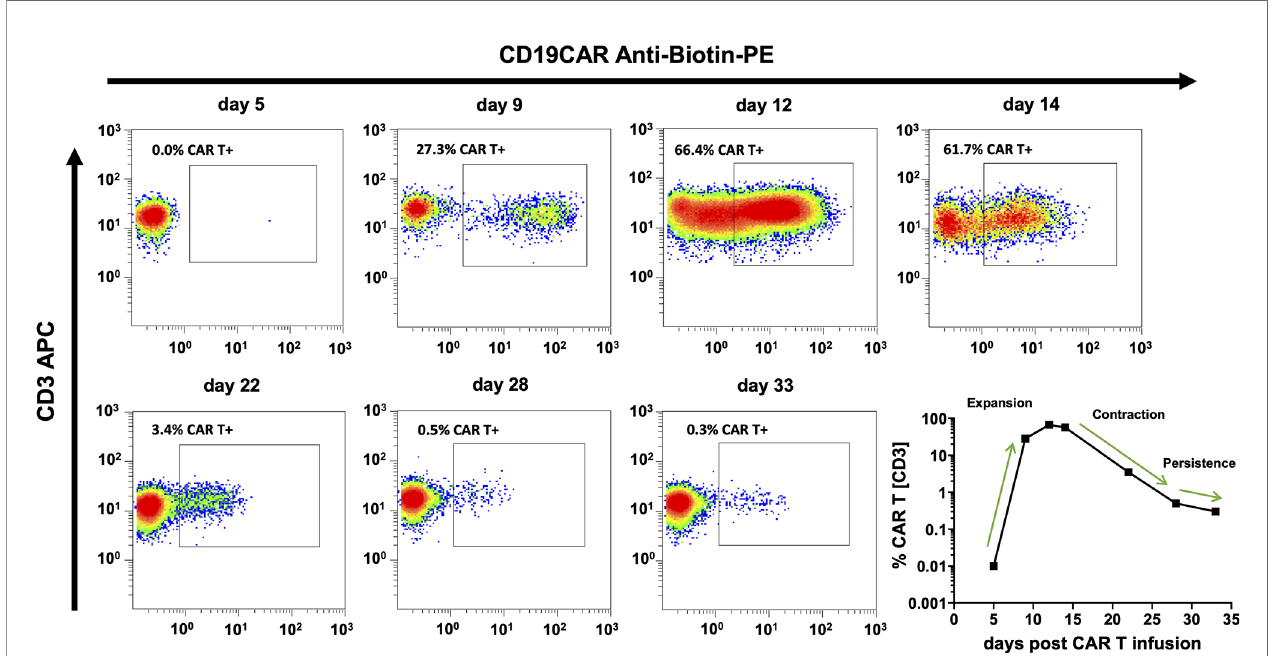
FIGURE 4 | CAR T cell monitoring curves match well with common models of CAR T cell cellular kinetics. CAR T cell cellular kinetics can be broken up into an initial period of exponential growth (expansion), a period of rapidly falling CAR T cell numbers (contraction), and a gradual decline over months or years (persistence). Flow cytometry plots and the bottom right curve depict the CAR T cell monitoring course of the same individual patient. Cellular kinetic phases can be easily identi fi ed and are indicated in the bottom right